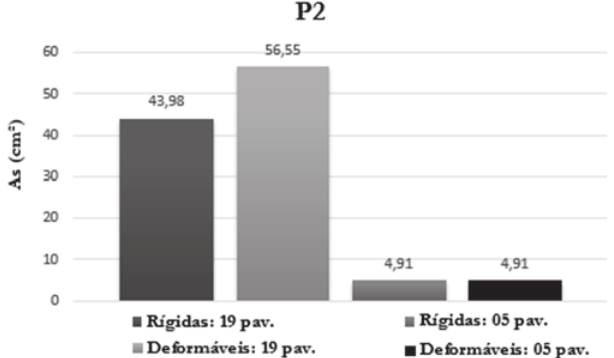
Figura 18 Modelo de Alva e El Debs [21]: armadura do pilar P2 da estrutura com 19 e 5 pavimentos, considerando γ ligações rígidas e ligações